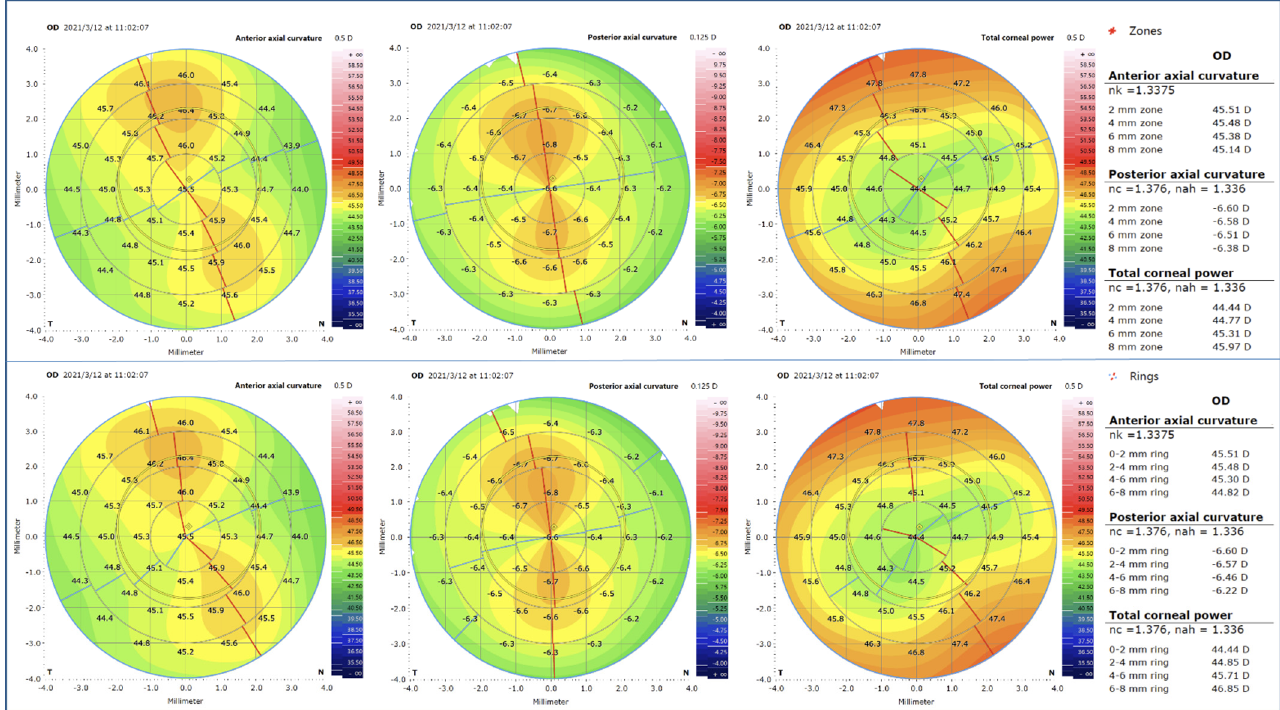
Figure 2. The anterior axial curvature, posterior corneal curvature, and total corneal power changes with different ring and zone diameters centered on the corneal vertex for a right eye. The first row was segmented by different diameter zones, and the second row was segmented by different diameter rings. The red and blue lines represent the meridian of steep and flat corneal curvature, respec- tively.